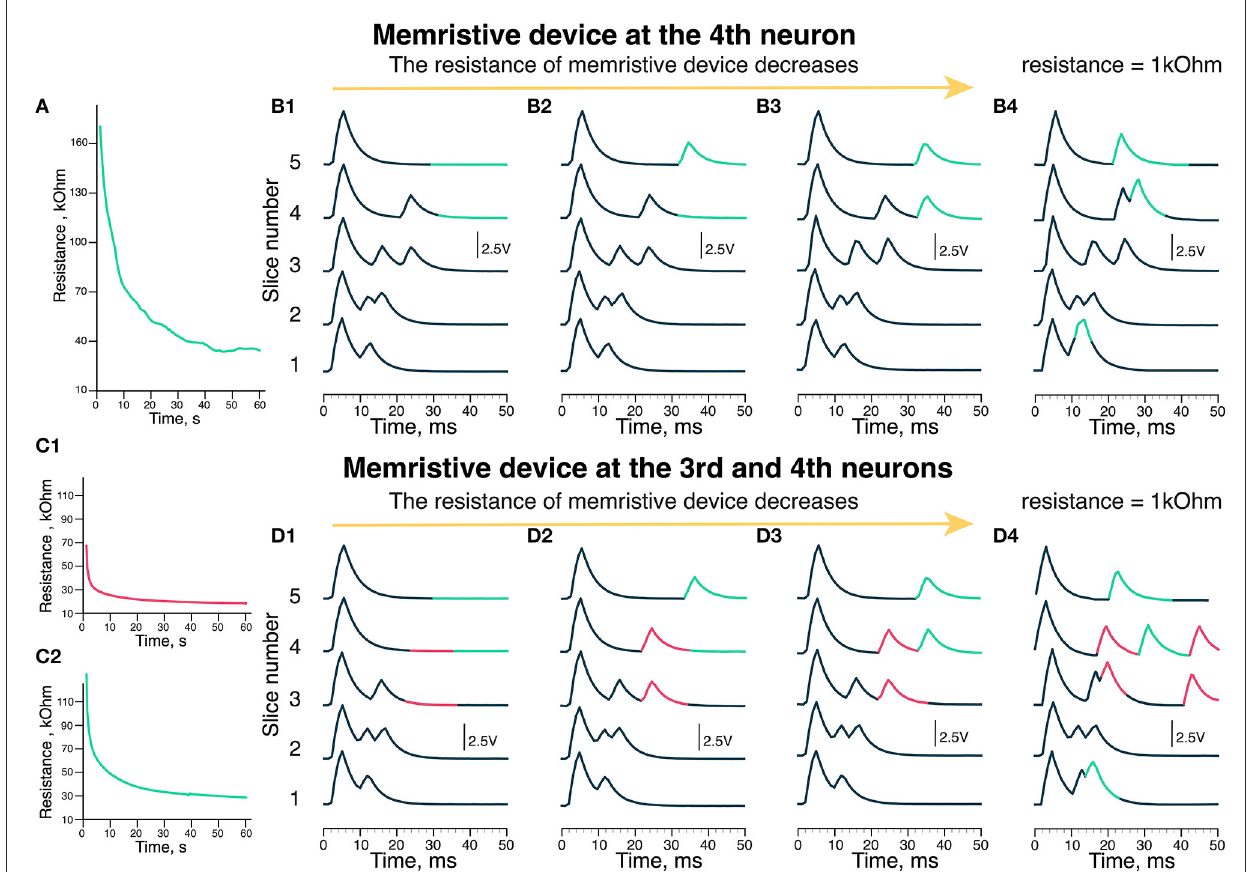
FIGURE3 Output of the scheme (MN membrane potential). (A) The update of memristive device resistance in green neuron. (B) The recordings of output voltage with different memristive device resistance: (B1) 170 kOhm, (B2) 60 kOhm, (B3) 30 kOhm, and (B4) 1 kOhm (Resistor). (C) The update of memristive deice resistance in (C1) pink and (C2) green neuron of the scheme. (D) The recordings of output voltage with different memristive devices resistance: (D1) 70 kOhm in pink neuron and 120 kOhm green neuron, (D2) 30 kOhm in pink and 40 kOhm in green neurons, (D3) 20 kOhm in pink and 30 kOhm in green neurons. (D4) 1 kOhm (Resistor) in pink and 1 kOhm (Resistor) in green neurons. (B4, D4) Are the experiments where we used resistors instead of memristive devices to reproduce the situation of extremely low resistance.